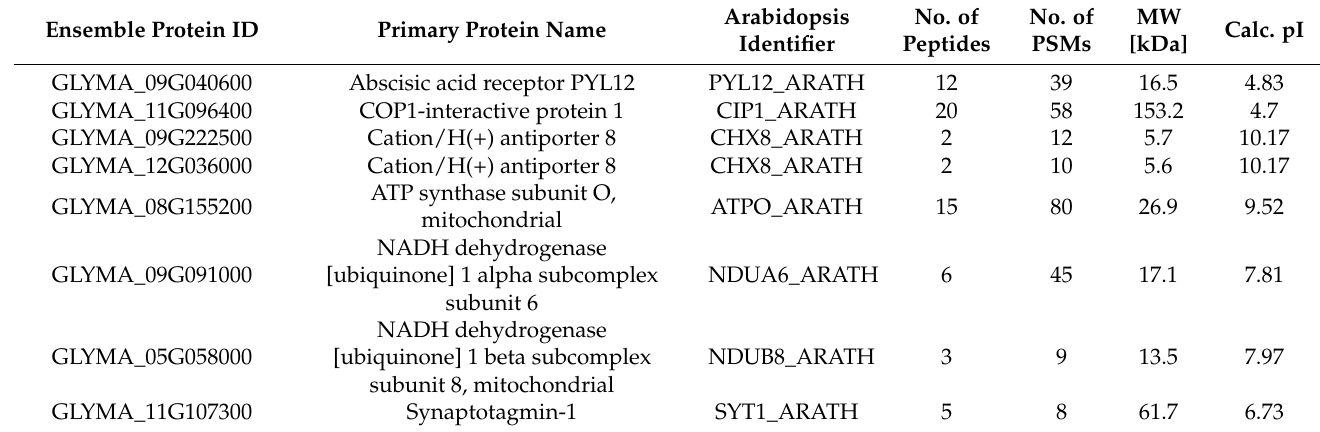
Figure 5. Up- and down-regulated membrane proteins in leaves identified using label-free quantification, with a − log 10 p -value > 0.05 and |fold-change| value > 0.5. Red dots represent up-regulated proteins and blue dots represent down-regulated proteins. Gray dots represent membrane proteins with unchanged expressions. Table 1. Up-regulated membrane proteins under salt stress in soybean leaves.